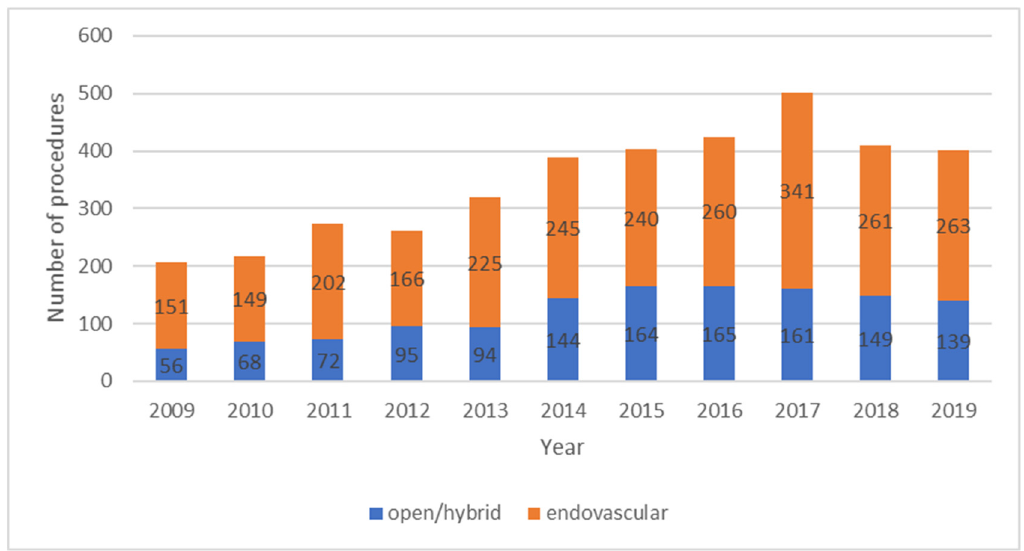
Figure 2. Number of vascular revascularization procedures carried out over the years by subtype.